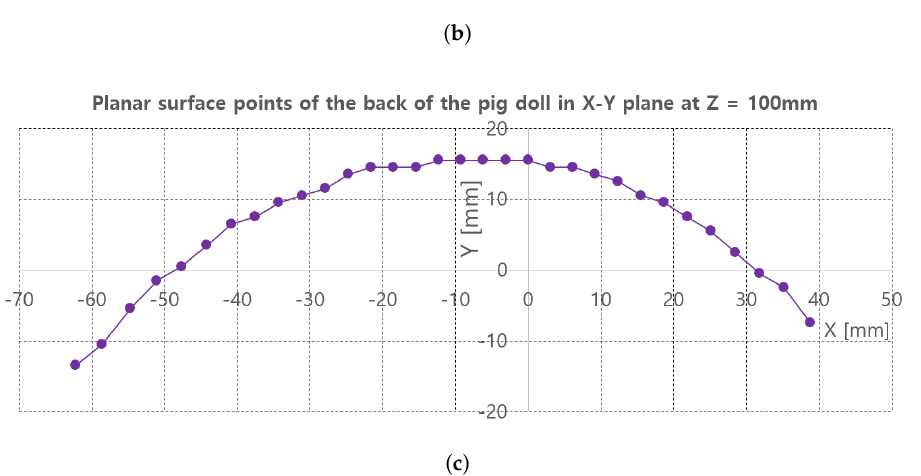
Figure 8. Points extraction from RGB-D data in Figure 7 for piecewise arc curve fitting. ( a ) X-Z plane view of all the D data points. ( b ) X-Y plane view of all the D data points. ( c ) Extracted points of back surface of the pig doll in X-Y plane at Z = 100